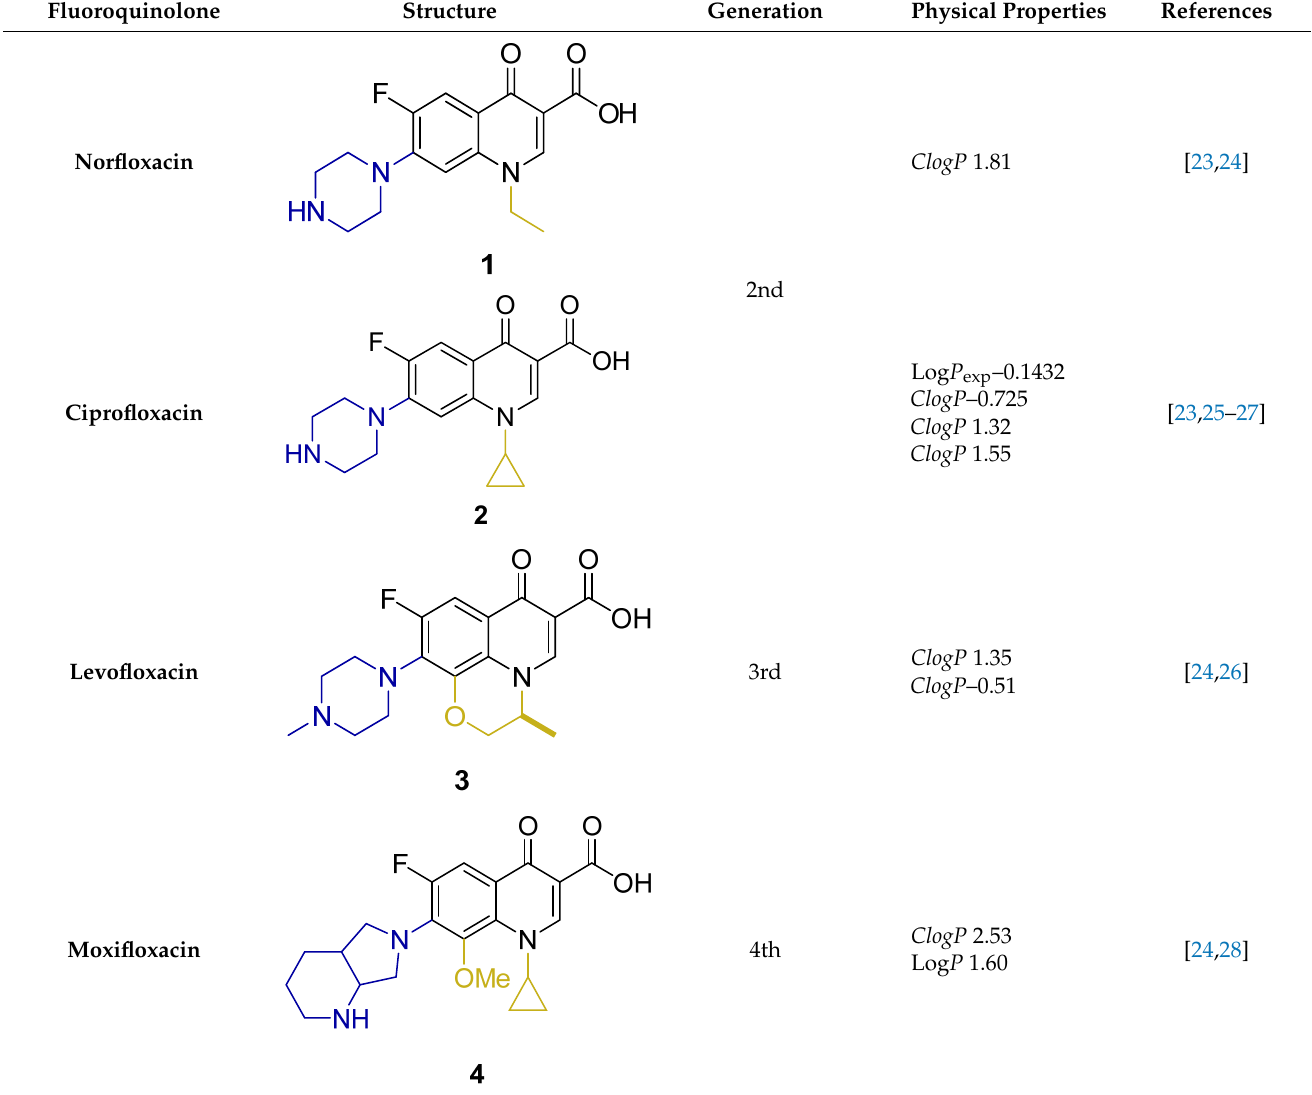
Table 1. Most adopted standard fluoroquinolones, their chemical structures, and key physical properties.